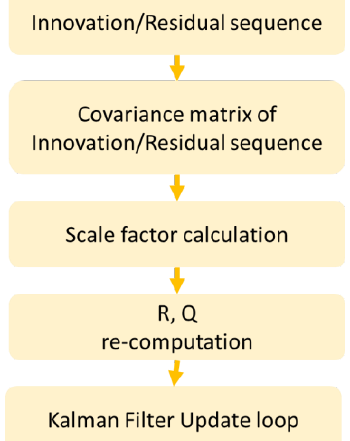
Figure 6. Flowchart of IBASE and